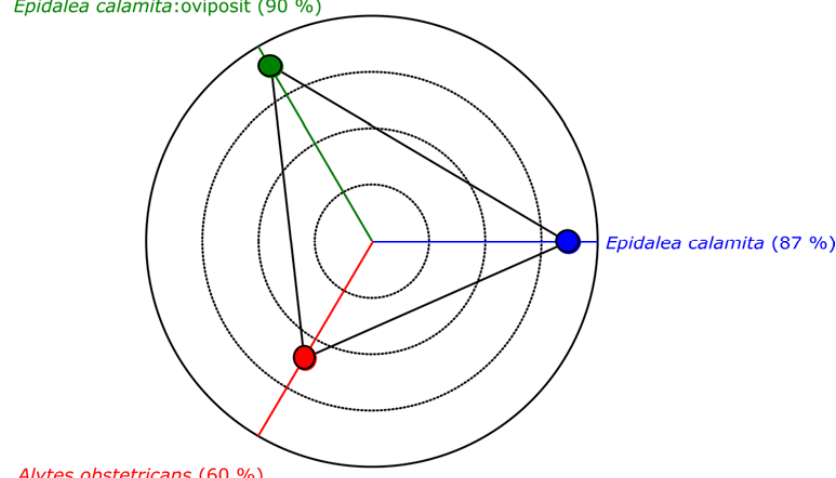
Figure 12. Performance of minimum distance classifier.